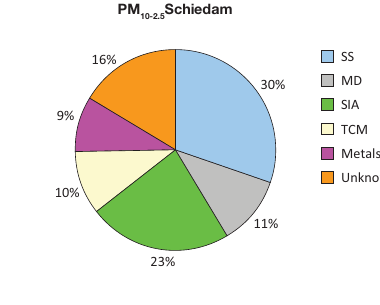
Fig. 4. Mass closures for the different fractions estimated at the urban background site Schiedam.